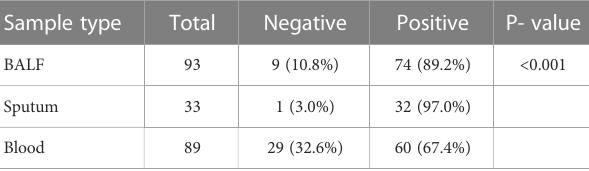
TABLE 2 Positive rate of pathogens detected by metagenomic next- generation sequencing in different sample types involving bronchoalveolar lavage fl uid, sputum, and